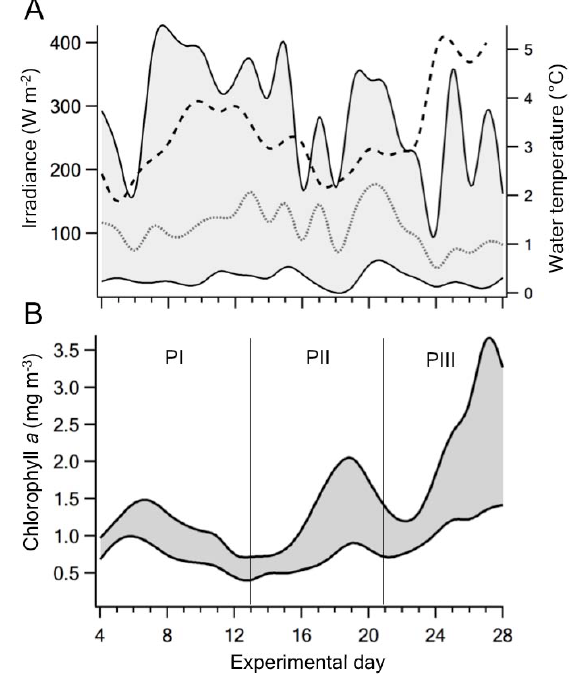
Fig. 1. Temporal change in environmental variables: (A) surface irradiance (PAR 400–750nm) and water temperature during the mesocosm experiment. The shaded area spans the range of mini- mum and maximum irradiance on each day and the dotted grey line represents the daily average value. The dashed line is the average water temperature in the mesocosm bags. (B) The grey shaded area spans the range of chlorophyll a concentrations measured in the nine mesocosms on each day. The vertical lines show the assigned phases (PI to PIII); nutrient addition occurred on